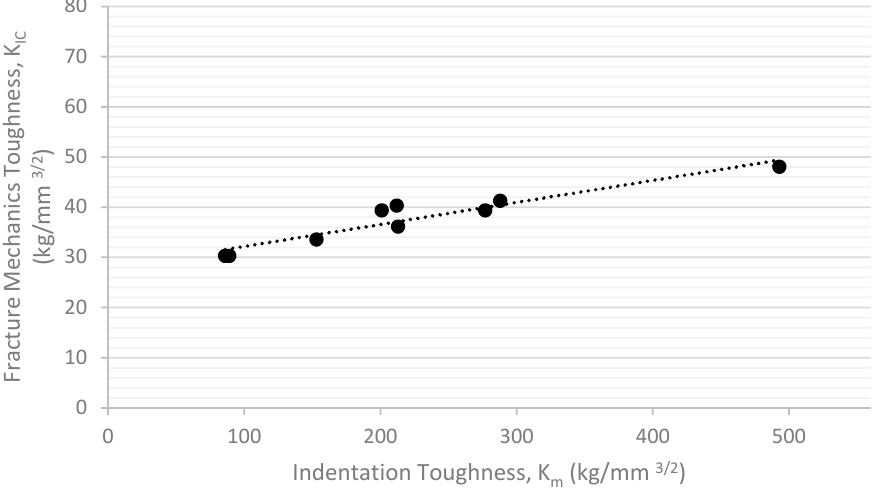
Figure 2. Indentation toughness ( K m ) versus fracture mechanics toughness ( K IC ), for WC-Co hardmetals.